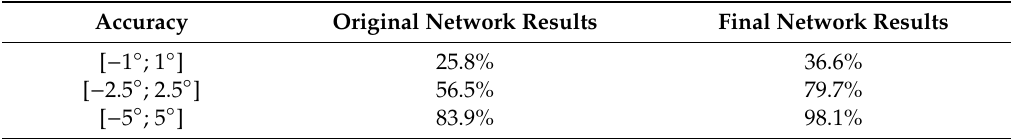
Table3. Networkaccuracies,quantifiedasthefractionofcorrectangulationmeasurements(withpredefined error intervals) compared to human reference measurements.